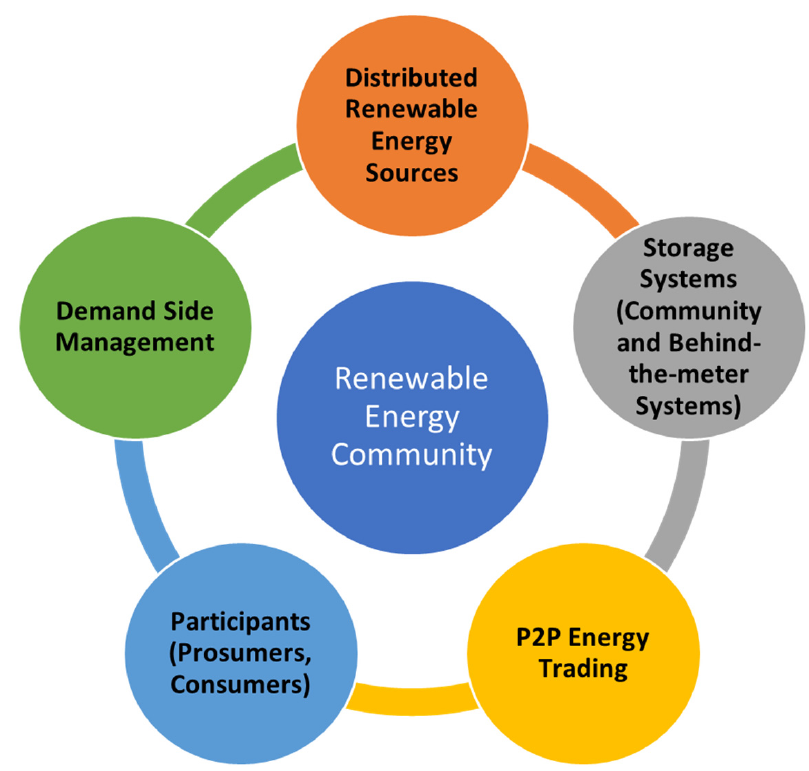
Figure 1. Block Diagram of the key elements in a Renewable Energy Community.